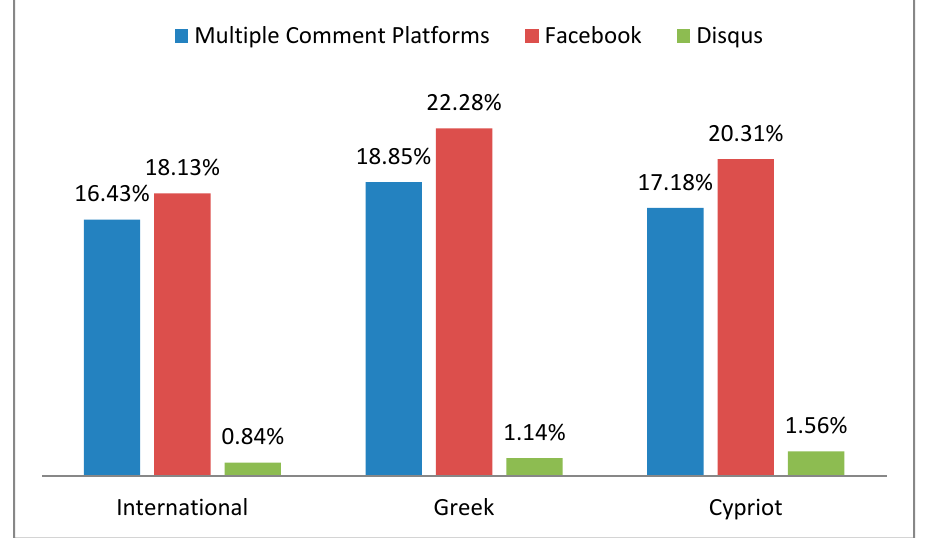
Future Internet 2019 , 11 , x FOR PEER REVIEW Figure 7. The Results of the Study for the First Research Question. Figure 7. The Results of the Study for the First Research Question.